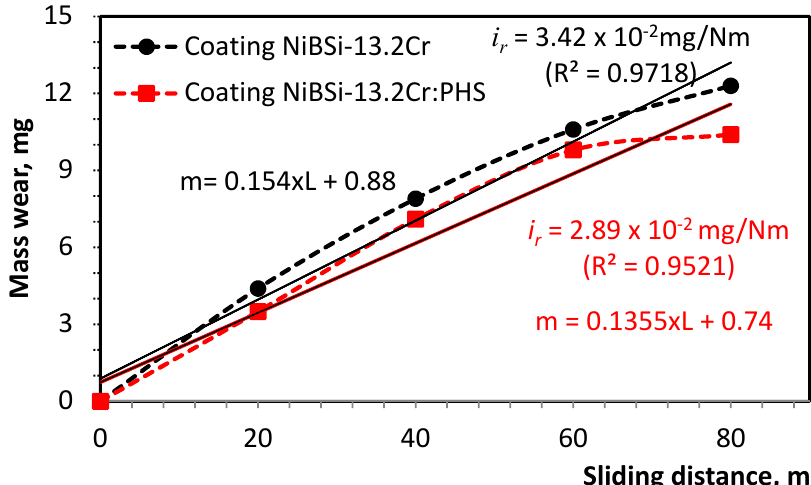
Figure 4. Mass wear vs. sliding distance for NiBSi-13.2Cr and NiBSi-13.2Cr: PHS coatings.